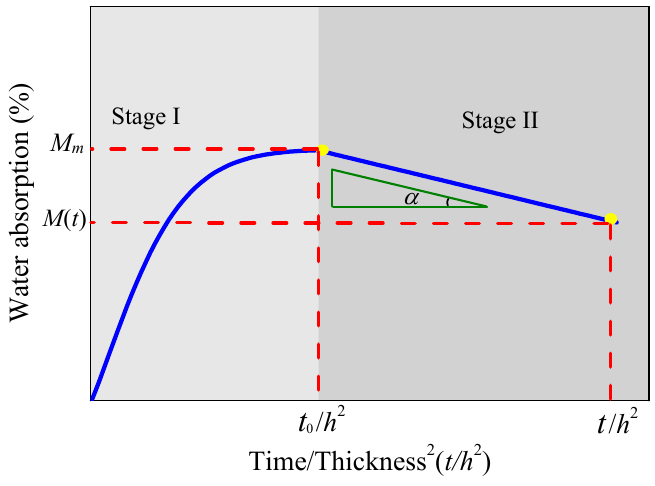
Figure 14. Two-stage model with the abscissa changed to t / h 2 . Figure 14. Two ‐ stage model with the abscissa changed to t / h 2 . Figure 14. Two ‐ stage model with the abscissa changed to t / h 2 .